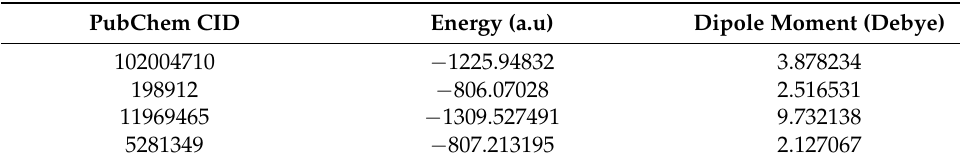
Figure 7. Optimized compounds of ( a ) PubChem CID: 102004710; ( b ) PubChem CID: 198912; ( c ) Pub- Chem CID: 11969465; ( d ) PubChem CID: 5281349, calculated by the B3LYP/6-31G (d, p) density functional theory. Table 5. Molecular structure energies and dipole moments of optimized molecules obtained through DFT